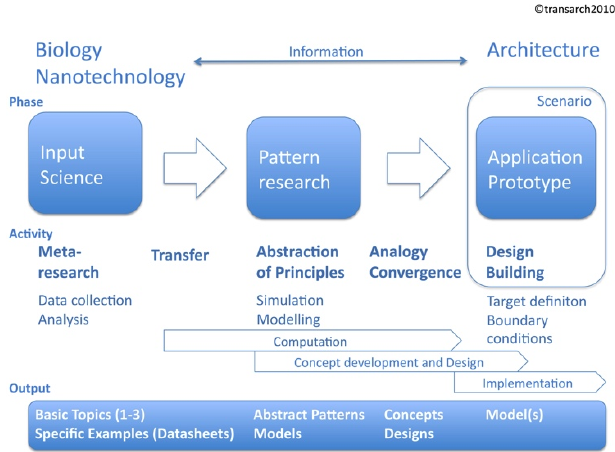
Figure 3. Study logic for biomimetics research and development.